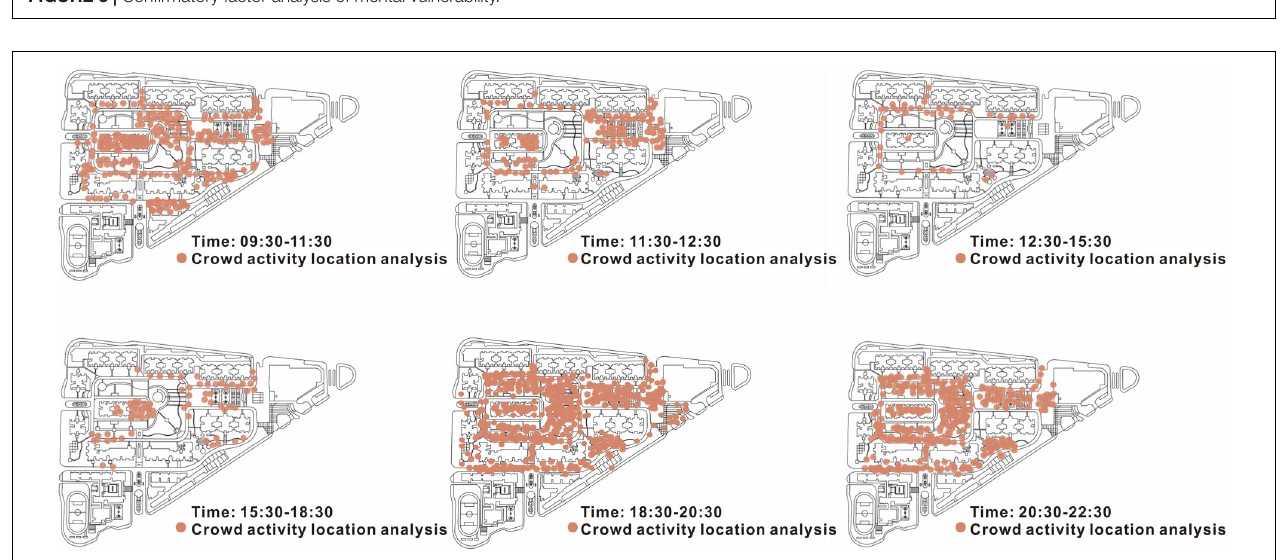
FIGURE 4 | Analysis of the locations of crowd activities in different